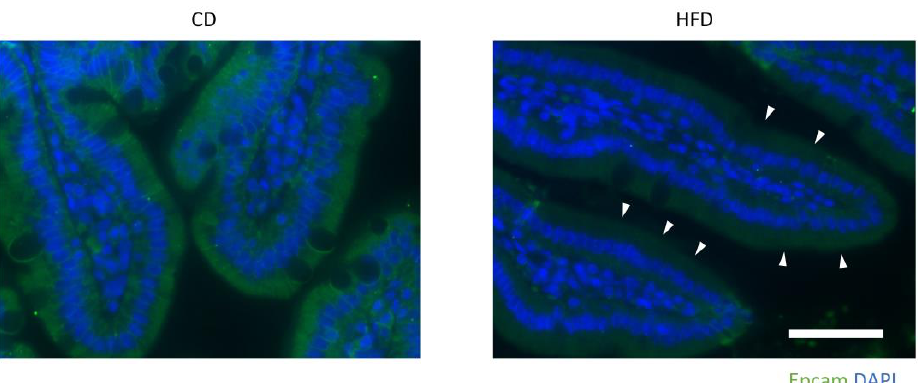
Figure 8. Representative immunohistological Epcam stained images of the upper small intestines from HFD- and CD-fed mice. Scale bar: 50 µ m. Arrowheads indicate decreased Epcam signal at the plasma membrane of IECs of HFD-fed mice.